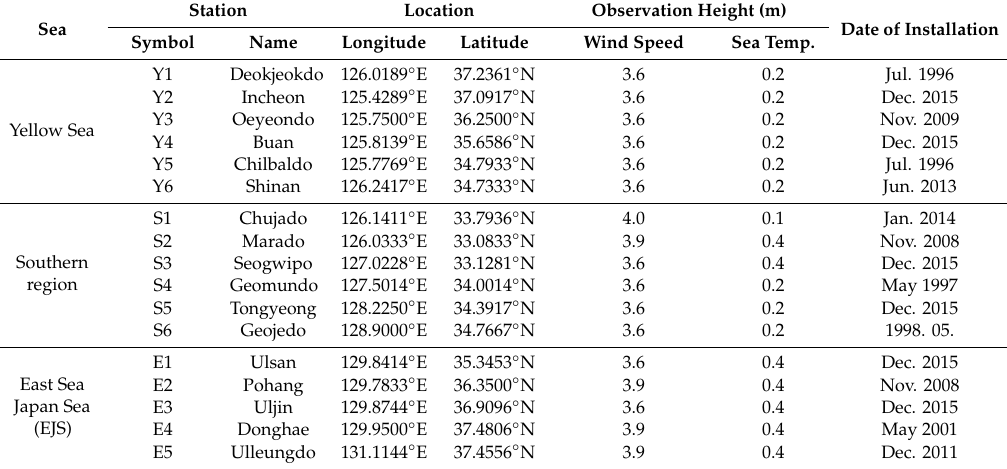
Table 1. Marine meteorological buoy station specification of Korea Meteorological Administration (KMA) in the seas around the Korean Peninsula including the measurement heights of wind speed and sea